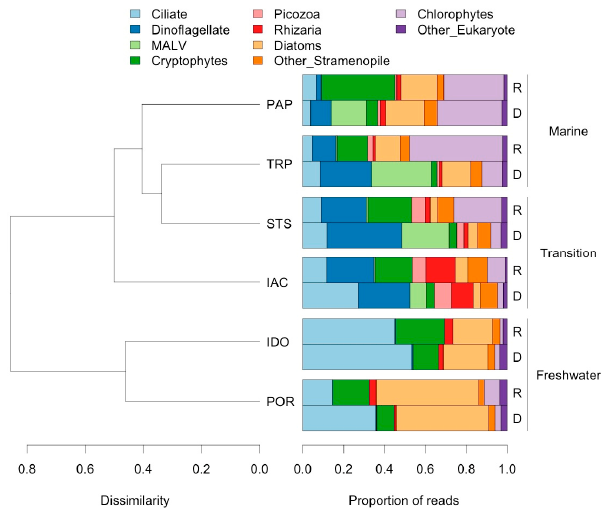
Figure 3. Samples clustered using unweighted UniFrac distances on eukaryote community, and proportion of reads belonging to major taxonomic groups based on 18S rRNA (“R”) and the 18S rDNA gene (“D”). Table 3. Similarity percentage (SIMPER) analysis listing the top 12 eukaryotic OTUs which contributed to the dissimilarity between freshwater (POR, IDO) and transition and marine sites (IAC, STS, TRP, PAP; full names of sites given in Table 2) for DNA- and RNA-amplified samples. (Cum. = Cumulative).